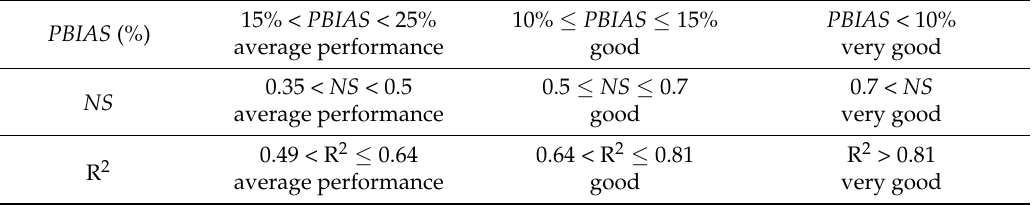
Figure 7. ( a ) Comparison of daily observed and simulated runoff and ( b ) comparison of simulated monthly areal evapotranspiration and MODIS-ET for R1 solution from single objective calibration. Table 2. Evaluation standard of hydrological indices for performance of model simulation